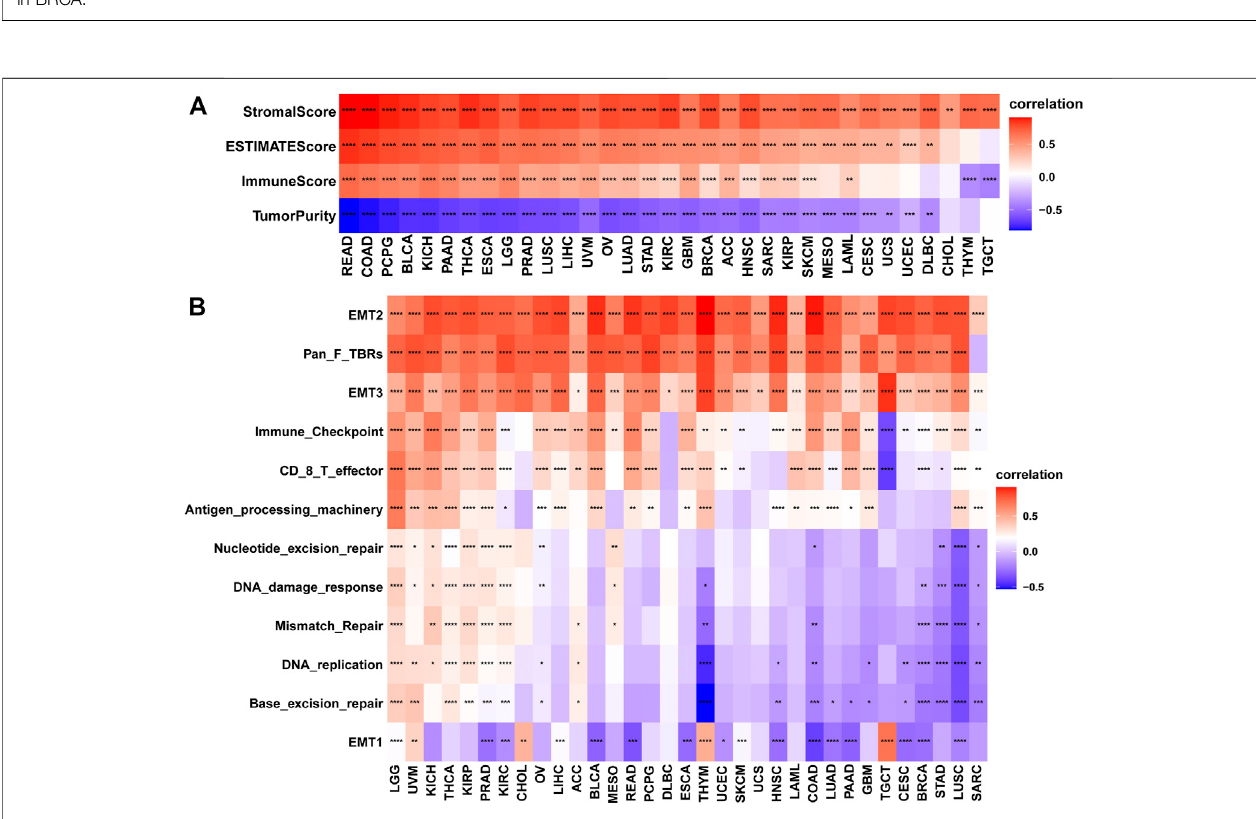
FIGURE4| Analysisofthe tumor microenvironment. (*** denotes p < 0.001, ** denotes p < 0.01, while *denotes p < 0.05) (A) .Correlationsbetween angiogenesis scores and ImmuneScores, Stromalcores, ESTIMATEScores and TumorPurity. (B) . Relationship between angiogenesis scores and pathways (Immune-related pathways, Stromal/transfer-related pathways and DNA damage repair-related pathways).